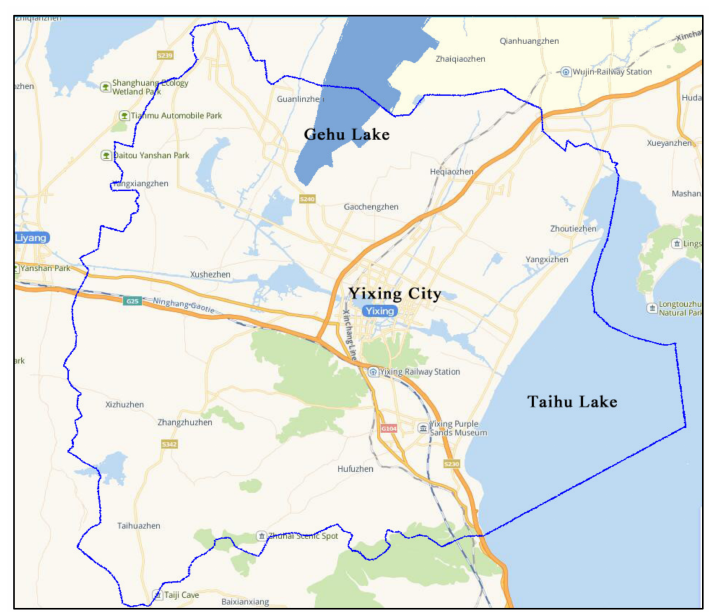
Figure 4. Location of Yixing City (the blue line represents the administrative region of Yixing City).